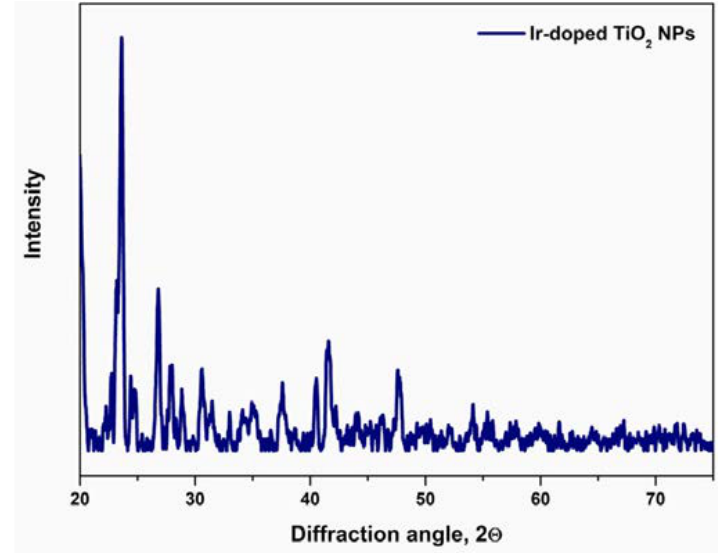
Fig. 4: Powder XRD pattern of Ir-doped TiO